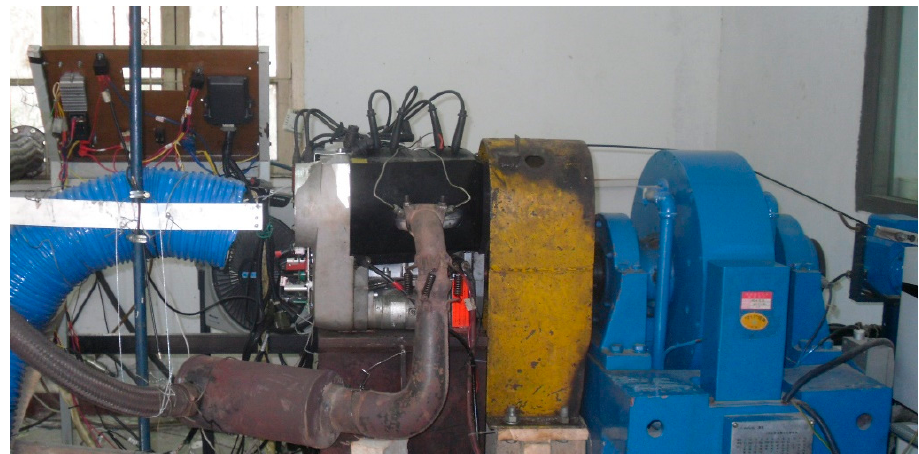
Figure 8. Schematic of the engine test bench.